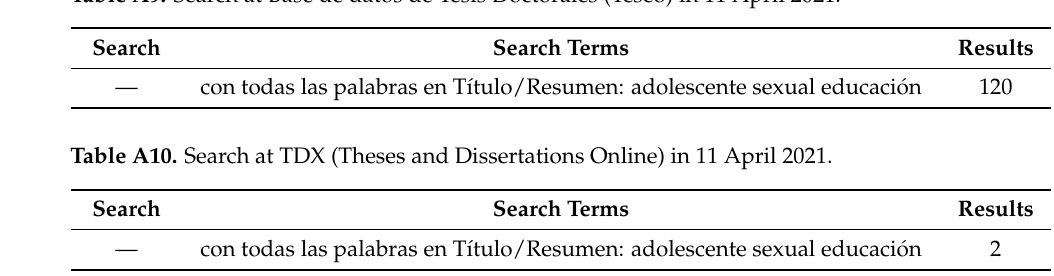
Table A9. Search at Base de datos de Tesis Doctorales (Teseo) in 11 April 2021.